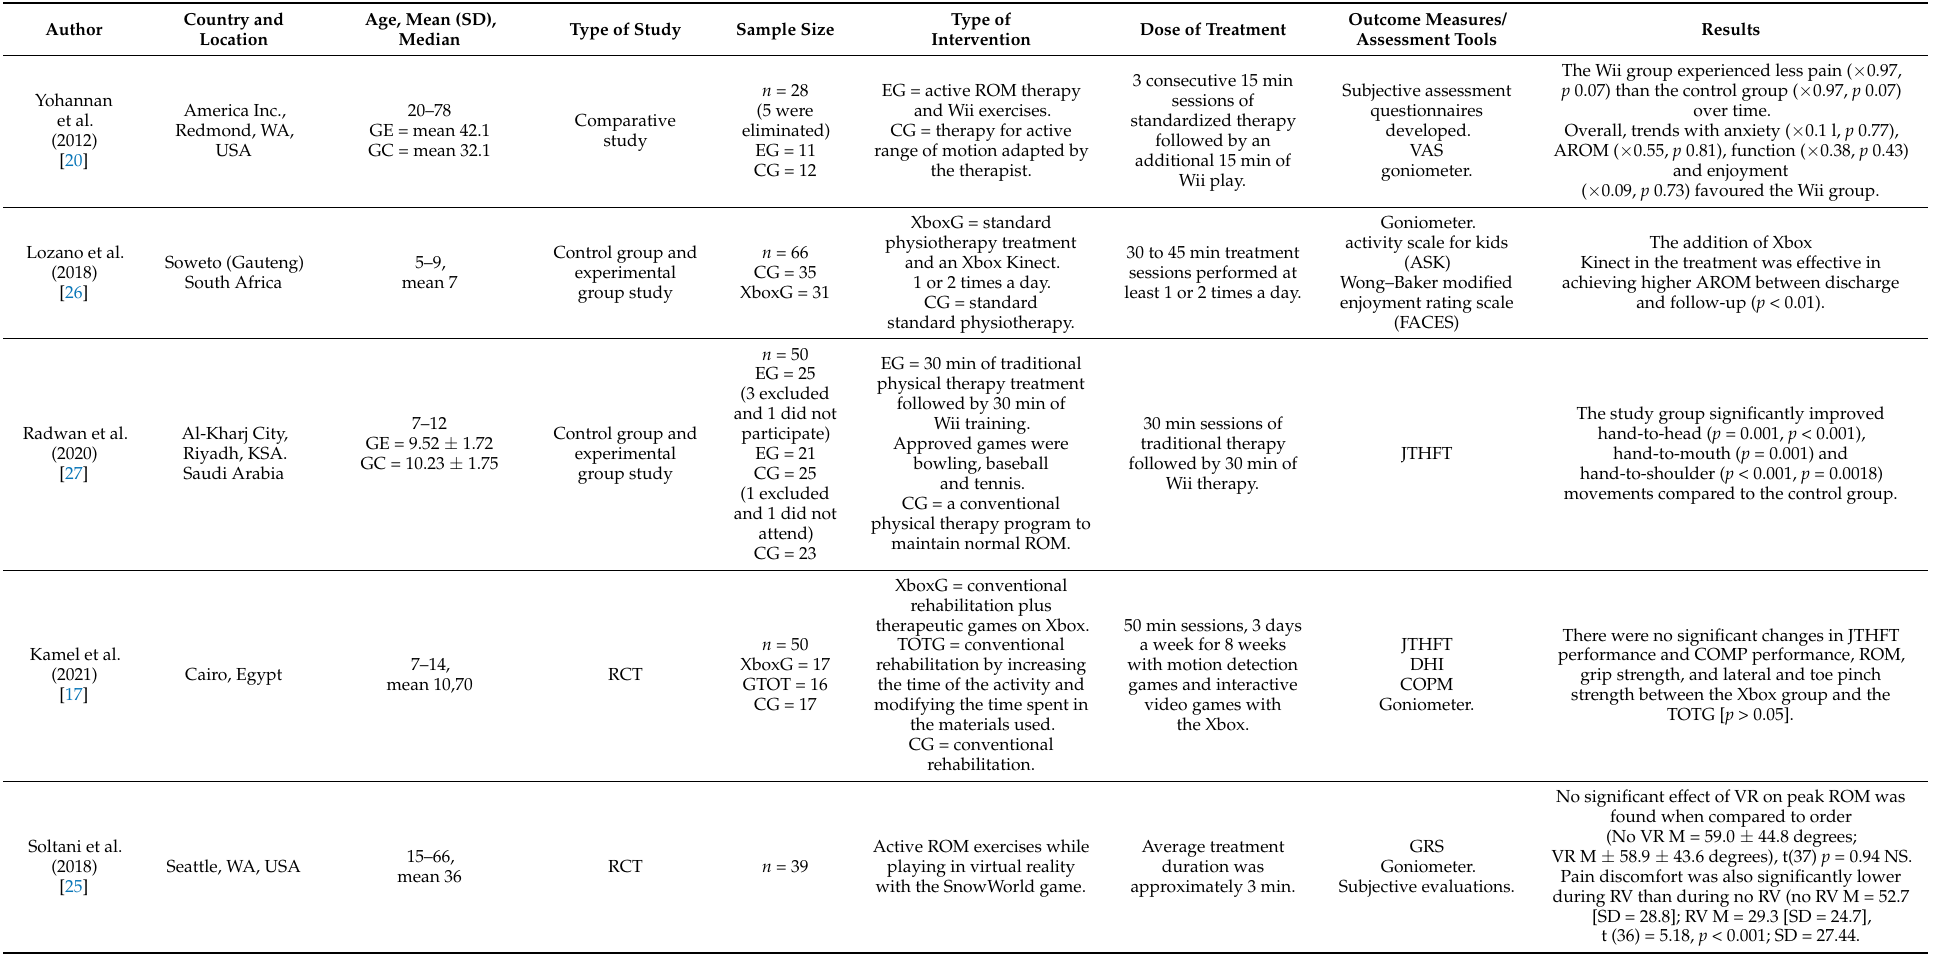
Table 2. Main characteristics of the